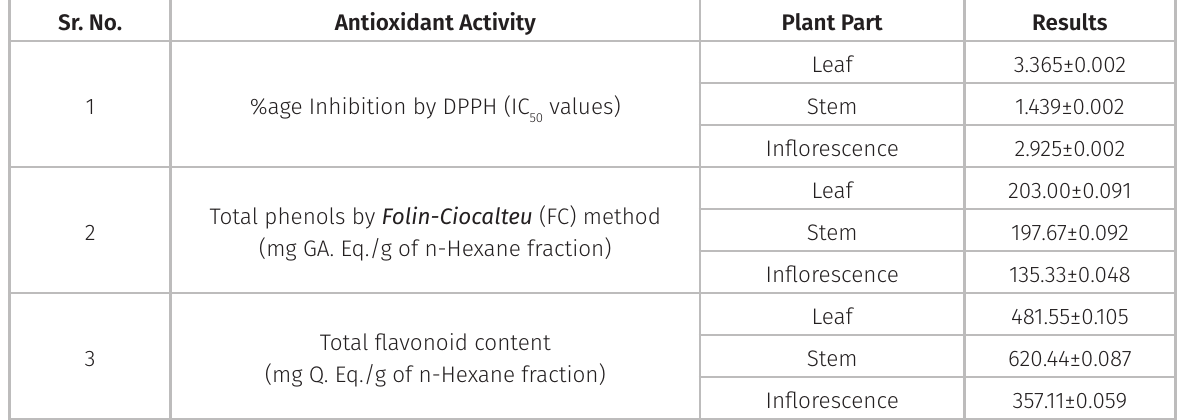
Table IV. Antioxidant activities of volatile chemical constituents of C. oppositifolia. Sr.